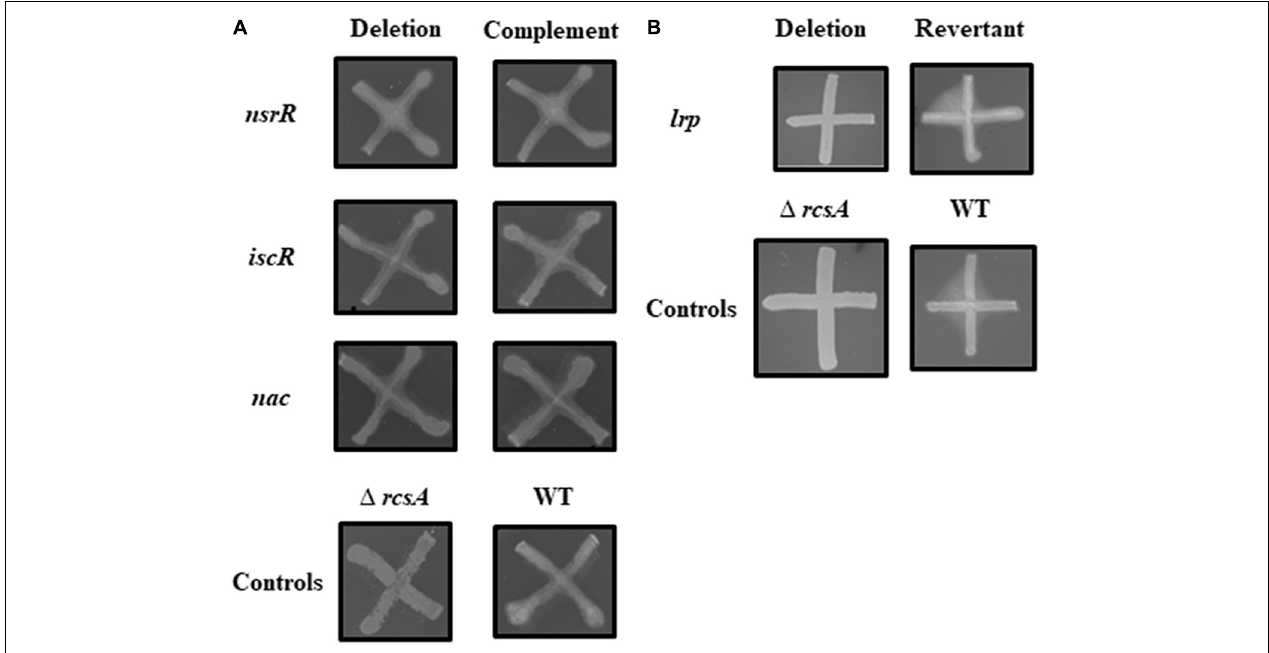
FIGURE 1 | Capsule production by P. stewartii nsrR , iscR , nac , and lrp mutant and complementation or revertant strains. All photographs, representative of duplicate or more samples, were taken at the same magnification after incubation in 30 ◦ C on CPG agar for 48 h (A) or 72 h (B) for the indicated strains.